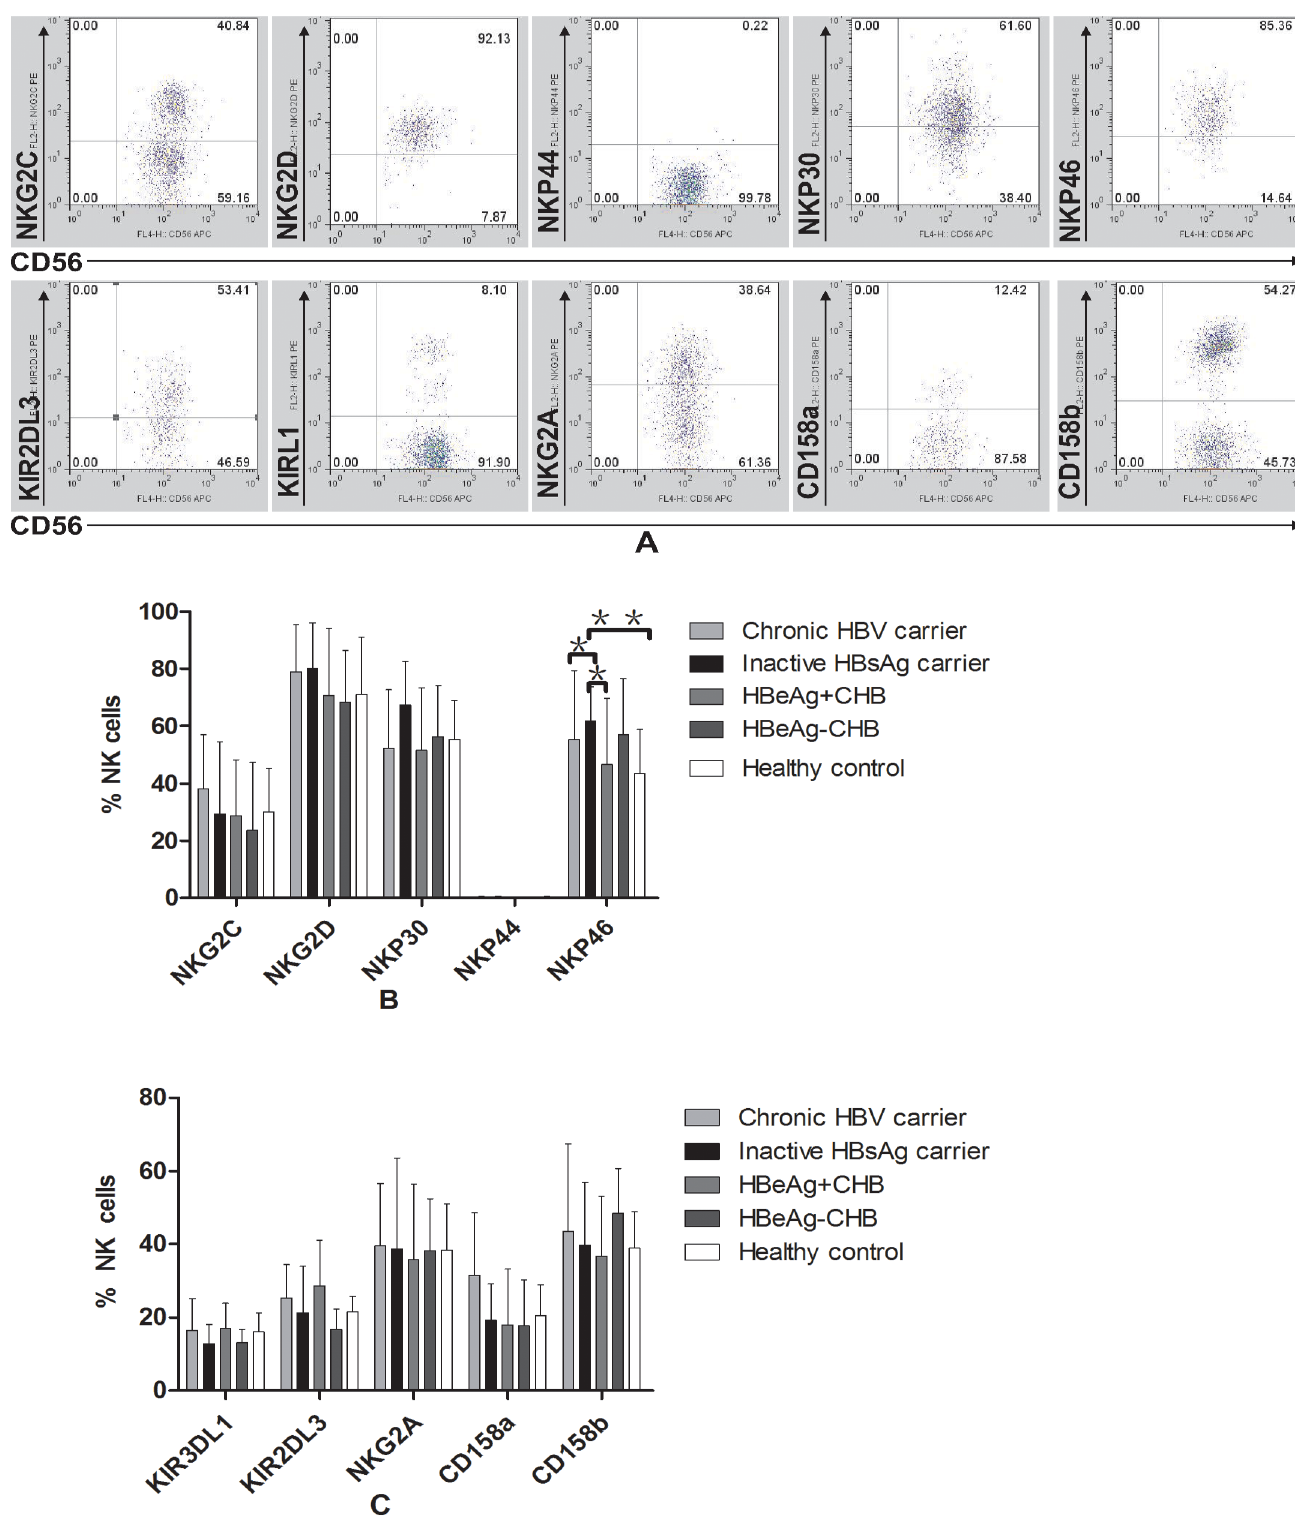
Fig 1. NK cells display abnormal NK receptor expression in CHB patients. (A) Representative dot plots depict NK activation receptor expression (NKp30, NKp44, NKp46, NKG2D and NKG2C) and inhibitory receptors (CD158a, CD158b, KIR2DL3, KIRL1 and NKG2A) in a CHB patient. Pooled data show the proportion of (B) NK cells expressing the NK activation receptors NKp30, NKp44, NKp46, NKG2D and NKG2C and (C) NK cells expressing the NK